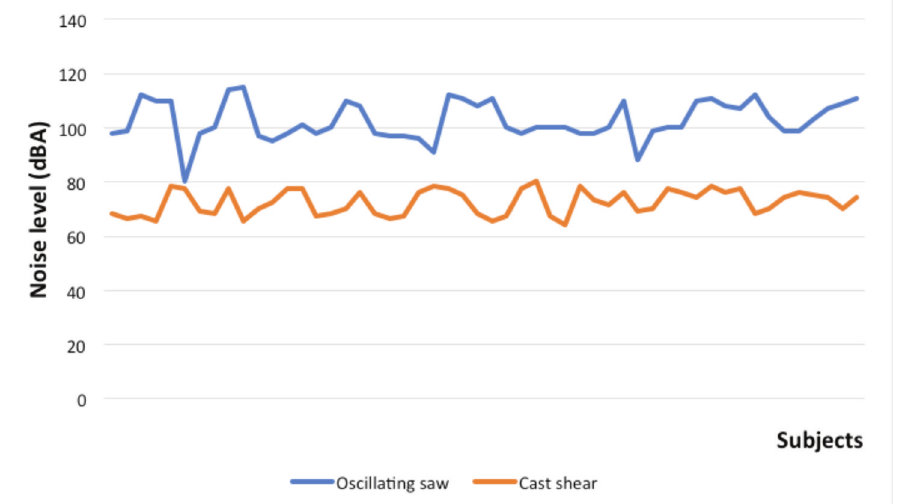
Cast room noise level during removal of cast in oscillating saw group and cast shear group. Y-axis: noise level measurements in Fig. 4: dBA. X-axis: individual